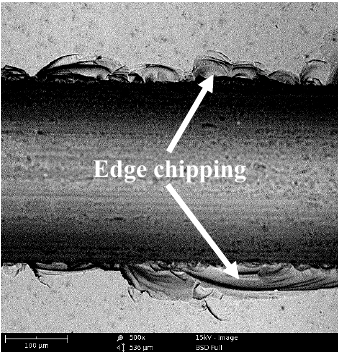
Figure 3. The edge chipping in sawing.